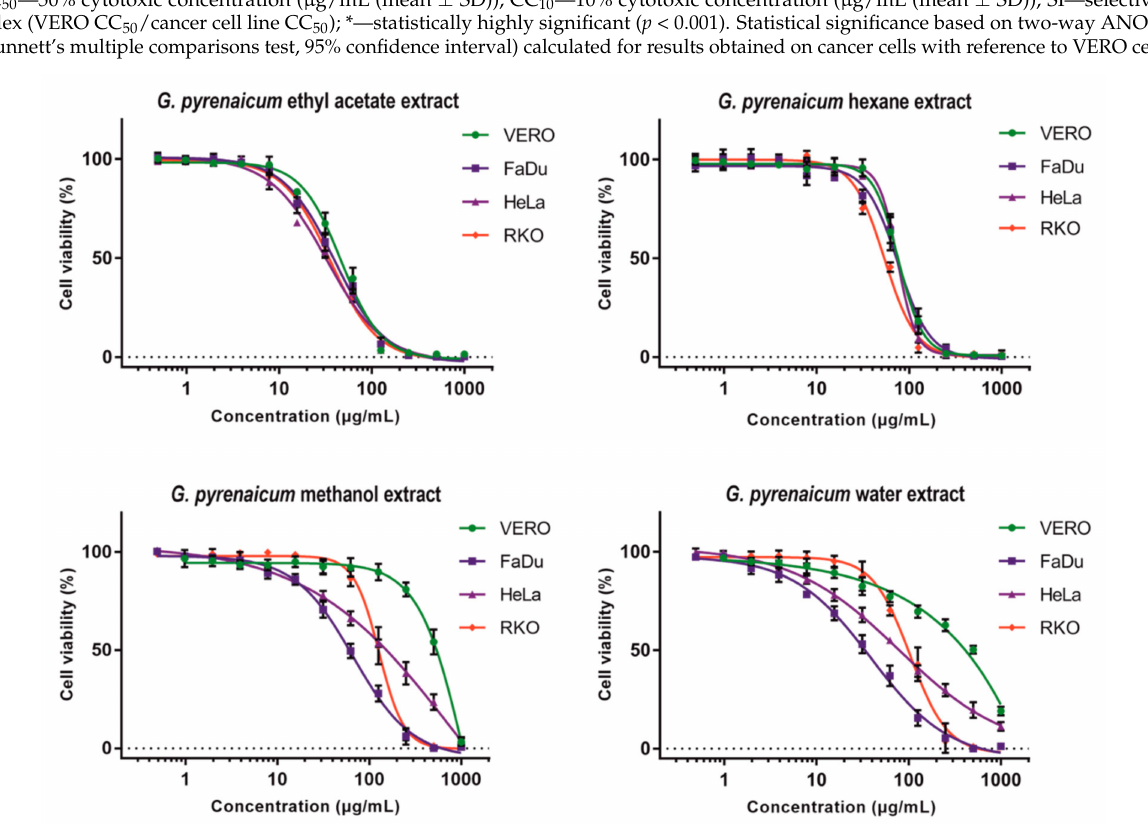
Figure 1. Dose–response influence of Geranium pyrenaicum extracts on cell lines. The Geranium maculatum ethanolic extract was reported to possess moderate (IG 50 (50% inhibitory growth) 60.2 µ g/mL) on MDA-MB-231 (human breast cancer) cells [68], which is similar to the activity we have observed for Geranium pyrenaicum methanol extract on FaDu cells (CC 50 66.92 µ g/mL). Graça, Barros, Calhelha, Dias, Carvalho, Santos-Buelga, Santos and Ferreira [24] reported the cytotoxicity of organic (n-hexane, dichloromethane, ethyl acetate, acetone and methanolic) and aqueous (infusion and decoction) extracts from Geranium robertianum L. towards MCF-7 (breast adenocarcinoma), NCI-H460 (non- small cell lung cancer), HeLa and HepG2 (hepatocellular carcinoma) cancer cell lines, as well as hepatotoxicity against non-tumor porcine liver primary cells (PLP2). The acetone extract exerted highest cytotoxicity against all tumor (GI 50 —50% of growth inhibition, 57–71 µ g/mL) and non-tumor (GI 50 176 µ g/mL) cell lines [24]. Interestingly, cytotoxic- ity of Geranium robertianum n-hexane extract was noticeably lower towards cancer